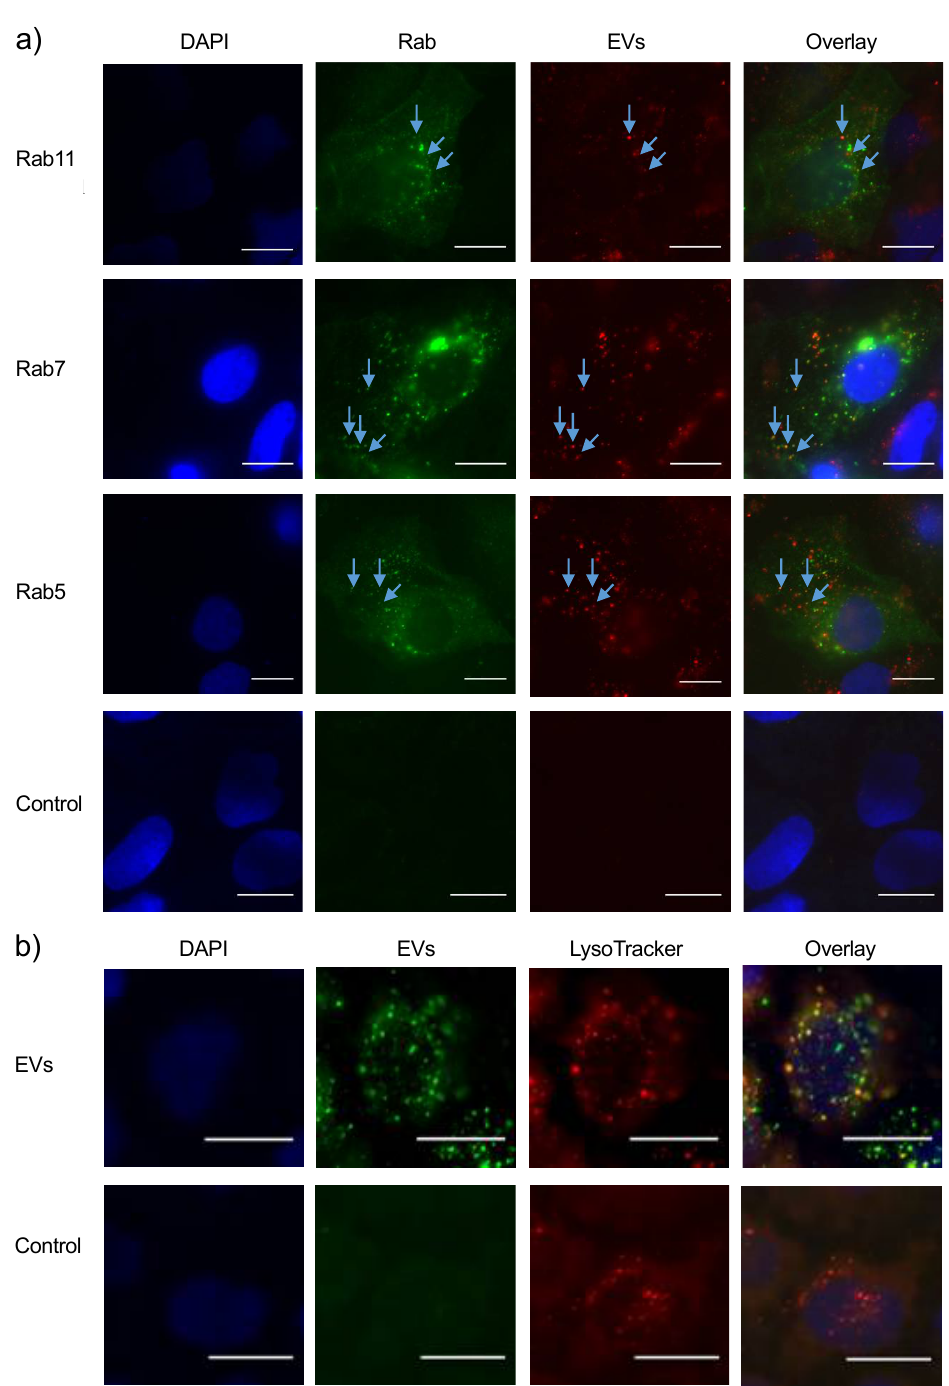
Figure 4. EVs are transported intracellularly via the endosomal system upon uptake. ( a ) EVs colocalize with early endosomes (Rab5), late endosomes (Rab7), and recycling endosomes (Rab 11), as indicated by the blue arrows on the overlaid images. The control has no EVs added. Scale bar 10 µm. ( b ) EVs also colocalize with lysosomes (labelled with LysoTracker), indicating that degradation of material occurs. Representative images were chosen for analysis. Incubation time with labelled EVs was four hours. Scale bar 10 µm.